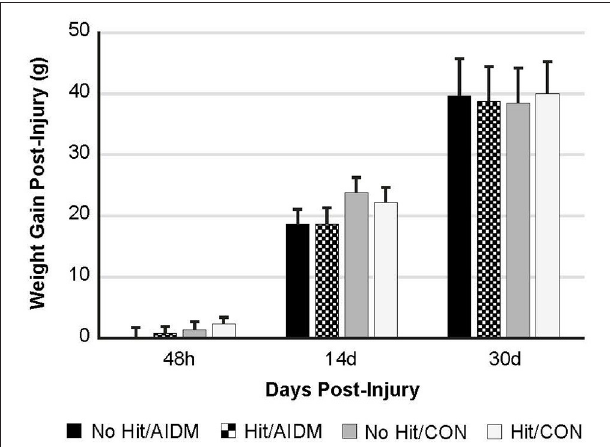
FIGURE 2 | Weight gain (grams) at 48h, 14 days, and 30 days following mTBI in rats consuming either anti-inflammatory (AIDM) or control (CON) diets. Rats were divided into TBI-exposed (Hit) or non-TBI (No Hit) control groups. Body weight was measured pre-injury and assigned a baseline zero value. Weight gain was measured just prior to euthanasia for tissue harvesting. There is no significant difference between groups at any of the three end-points of 48h, 14 days, and 30 days. Bar heights represent mean value ± SDEV for n = 30 rats/group at 48h, and n = 24 rats/group at 14 days, and n = 12 rats/group at 30 days.